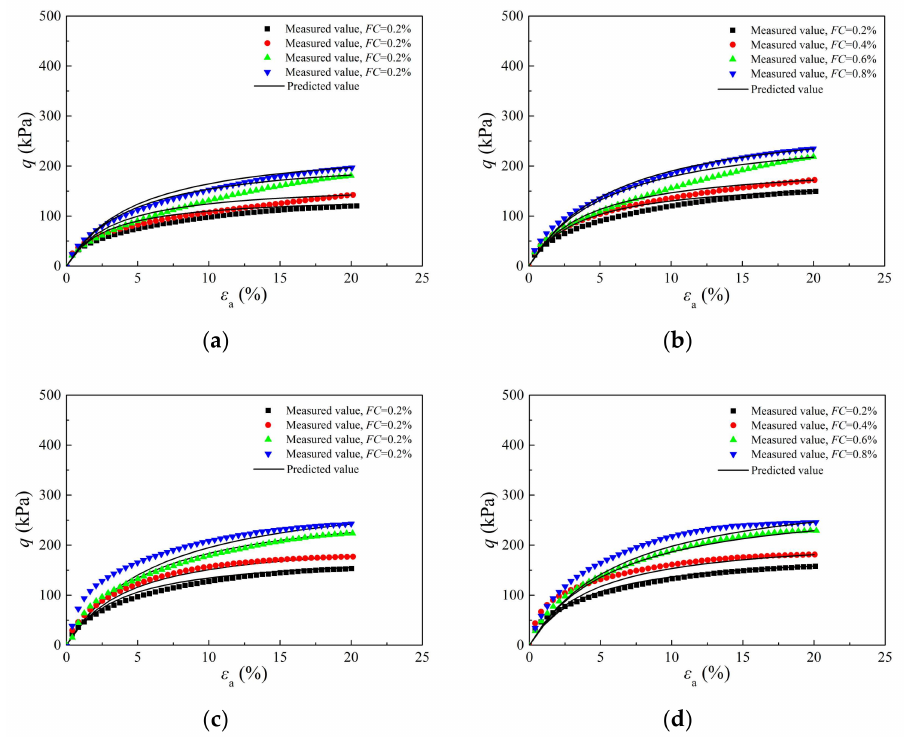
Figure 9. Results comparison between measured and predicted results under 50 kPa cell